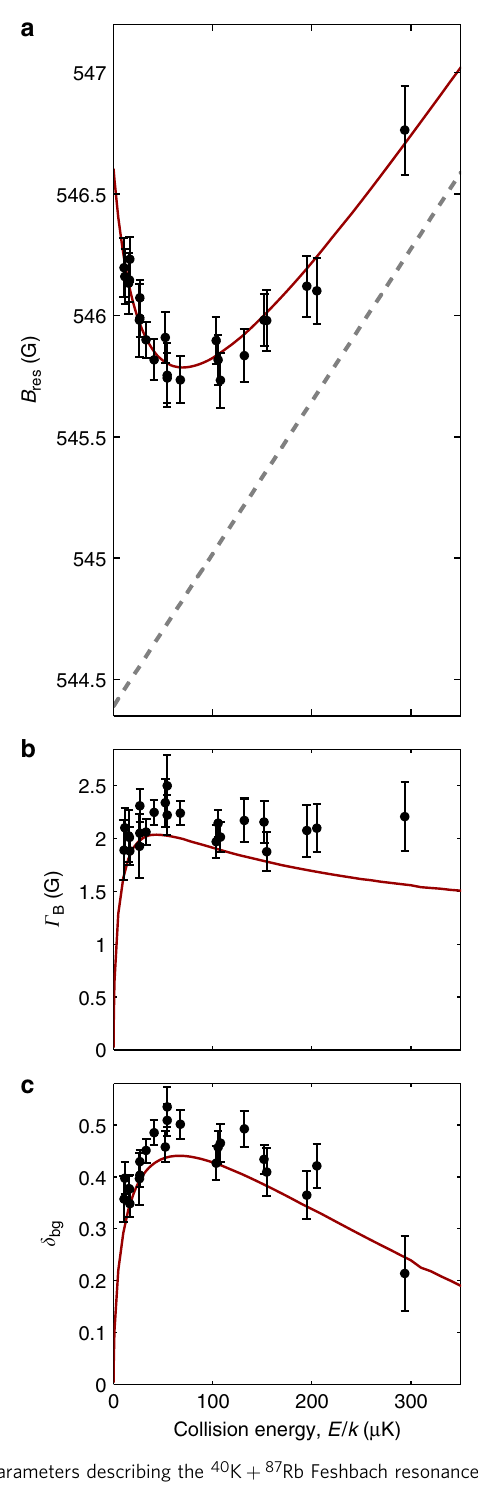
Fig. 4 Parameters describing the 40 K + 87 Rb Feshbach resonance. a – c Resonance position B res , width Γ B , and background phase shift δ bg as a function of collision energy E for the resonance near 546 G. Solid lines are predictions from a coupled-channels model. Circles are measurements using the collider, and error bars are the one standard deviation uncertainty obtained from the fi ts to Eqs. (5) and (6). The dashed grey line in a indicates the resonance position in the absence of self-energy effects extrapolated from the asymptotic behaviour of the fi tted model for B E res (